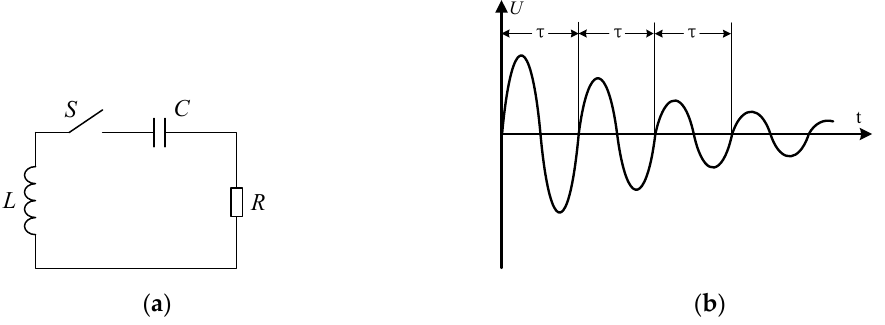
Figure 3. The attenuation characteristics of power. ( a ) The zero-input second-order circuit, ( b ) the second-order oscillation attenuation waveform.